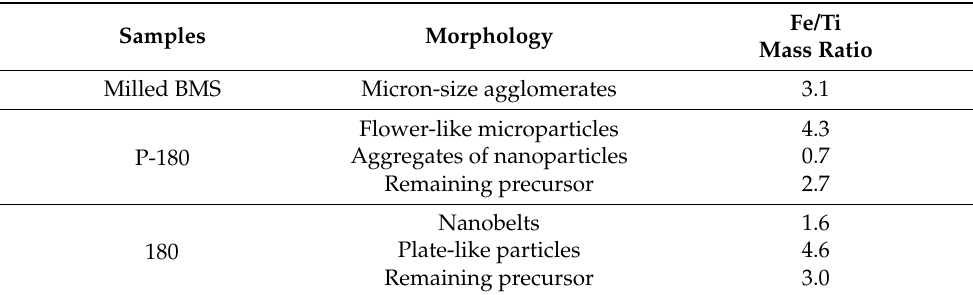
Table 4. Fe/Ti mass ratio obtained by semiquantitative EDS analyses for milled BMS and each morphology within the as-synthetized